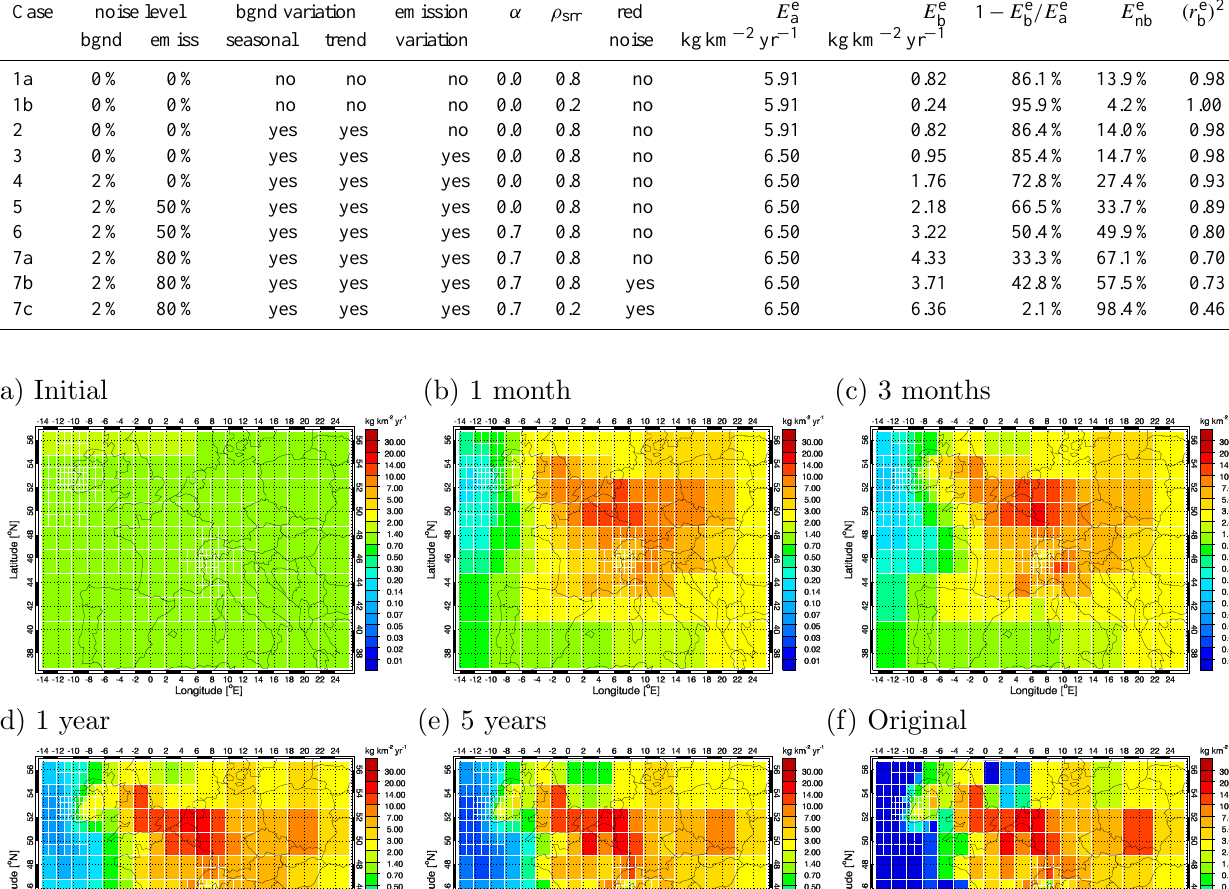
Table 2. Setup and performance of synthetic simulations. Settings common to all simulations are ρ min = 6 . 6ppt, ρ obs = 0 . 01, η e = 0 . 01,